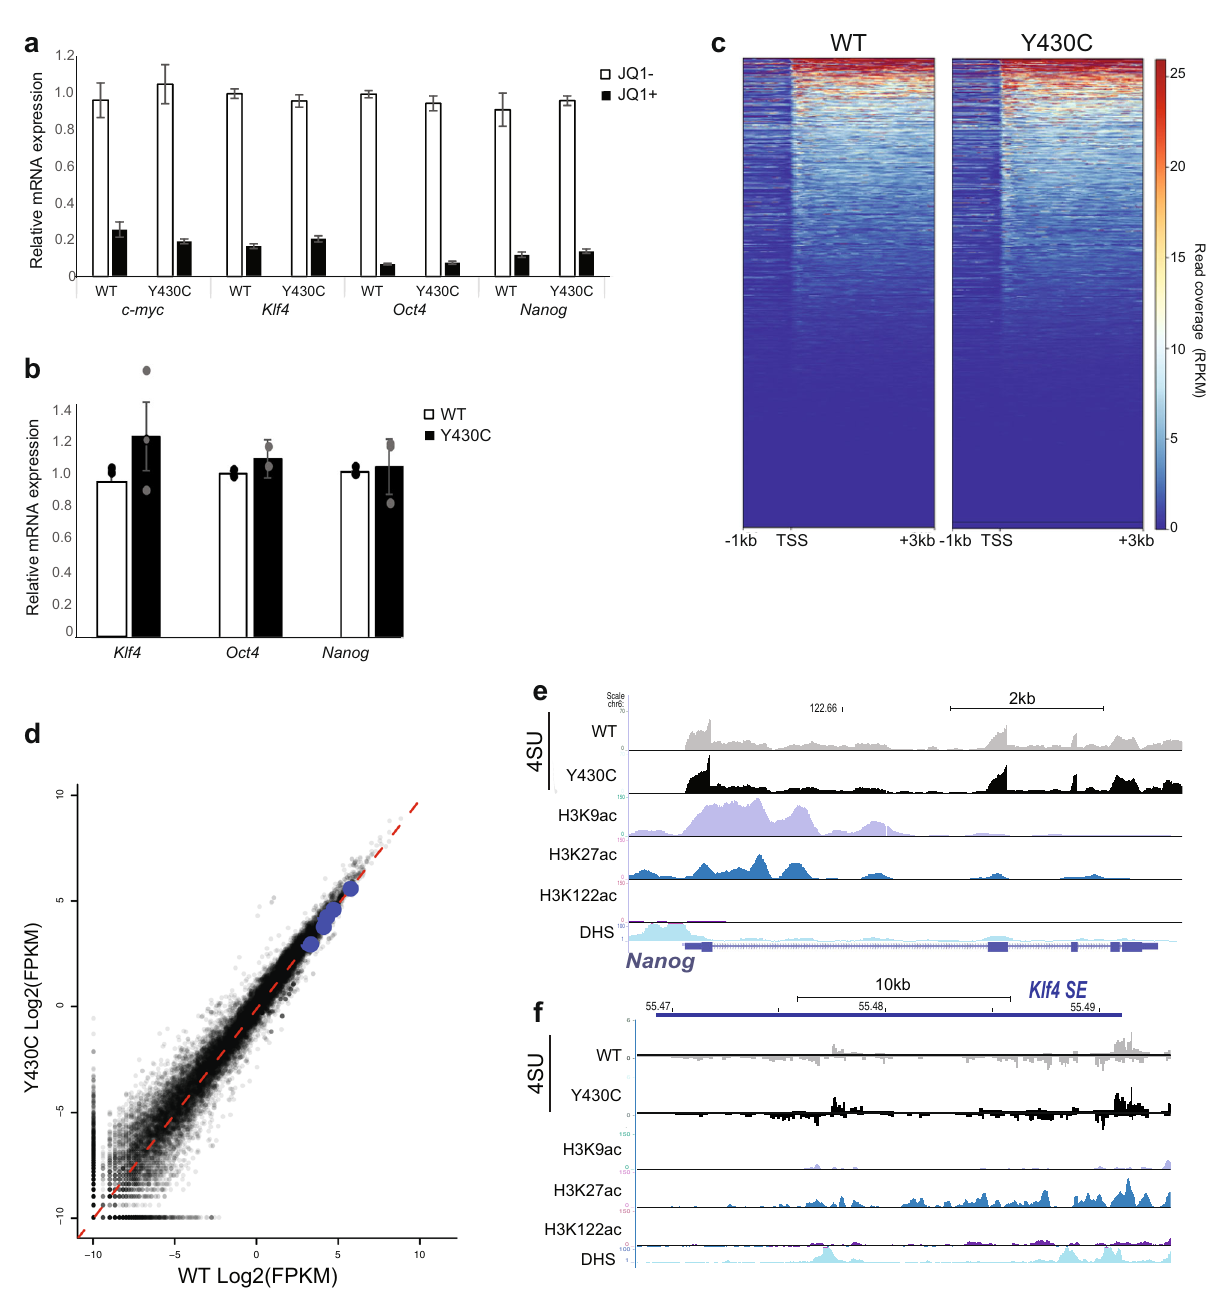
Fig. 2 Similar transcription in WT and Y430C mESCs. a RT-qPCR measuring mRNA of c-myc, Klf4, Oct4 and Nanog in mESCs after treatment with 300 nM JQ1 + , relative to that in untreated cells (JQ1-). Data are represented as mean ± SEM from 3 technical replicates. b RT-qPCR measuring mRNA for Klf4, Oct4 and Nanog in WT and Y430C mESCs. mRNA concentration is shown relative to WT set at 1. Data are represented as mean ± SEM from 3 biological replicates. c Heatmaps show enrichment of 4sU-seq data in WT and Y430C cells over transcribed regions ( − 1kb, TSS and + 3 kb) (mm9_refseq). d Scatter plot of the 4sU-seq data in WT and Y430C cells, highlighting pluripotency genes in blue (Nanog, Sox2, Klf4, Esrrb, Pou5f1). Red dashed line shows best fi tted line. Pearson correlation coef fi cient = 0.98. e , f UCSC browser screenshot showing 4SU-seq reads per 10 million over e the Nanog locus and f the Klf4 super-enhancer in WT and Y430C cells and ChIP-seq tracks for various histone modi fi cations and DNaseI hypersensitivity in WT cells. Genome co- ordinates (Mb) are from the mm9 assembly of the mouse genome. Data from a biological replicate Y430C clone are in Supplementary Fig.